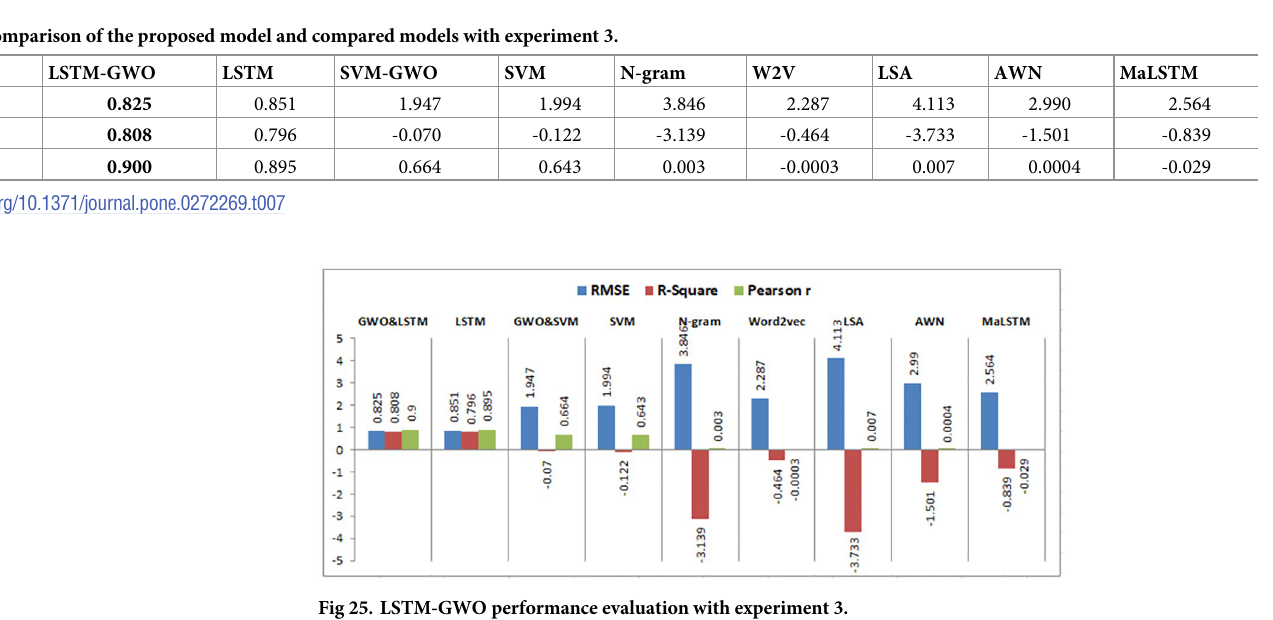
Using the dataset of 47148 answers, Fig 27 displays the suggested LSTM-GWO model per- formance evaluation with various methods. Table 10 introduces the comparison results of the proposed model with compared models in auto-grading over 58831 short answers. As illustrated in Table 10, the proposed model achieved the best results. Although the LSTM model has the same Pearson r value, the